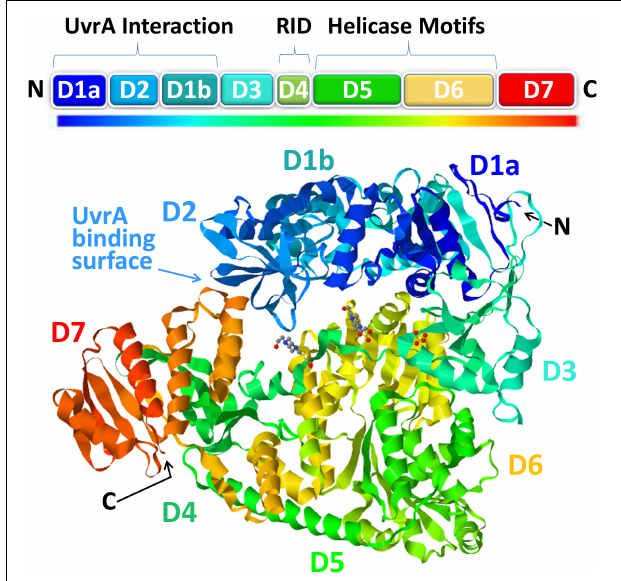
FIGURE 2 | The structure of mutation frequency decline (Mfd). The modular Mfd protein consists of eight domains indicated as boxes in the cartoon (top) and as a rainbow ribbon representation of the crystal structure [PDB ID: 2EYQ (Deaconescu et al., 2006)] viewed with JSmol (bottom). The N-terminus (N) contains the UvrA interaction region (D1a, D2, D1b) which is structurally homologous to the region of UvrB that binds to UvrA. This region of the protein is sequestered in a locked state via interactions with the D7 autoinhibitory domain in the C-terminus (C). Upon interaction with stalled RNAP, the D4 domain, containing the RNA polymerase (RNAP)-interacting domain (RID), binds to the β ’ subunit of RNAP which triggers ATP hydrolysis by the helicase motifs in D5-D6 and subsequent DNA translocation and rearrangements ultimately resulting in release of the nascent RNA, removal of RNAP, and recruitment of UvrA 2 B repair